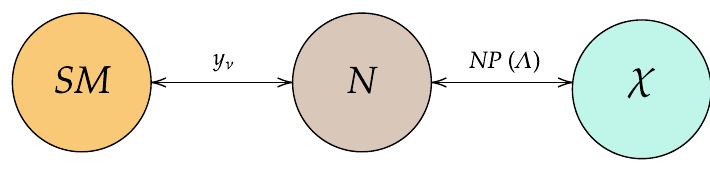
Figure 1 . Schematic diagram of the considered set-up, in which the sterile neutrino N serves as a portal between the SM and the dark sector containing the DM χ . NP stands for new physics generating effective four-fermion interactions between N and χ at the scale Λ